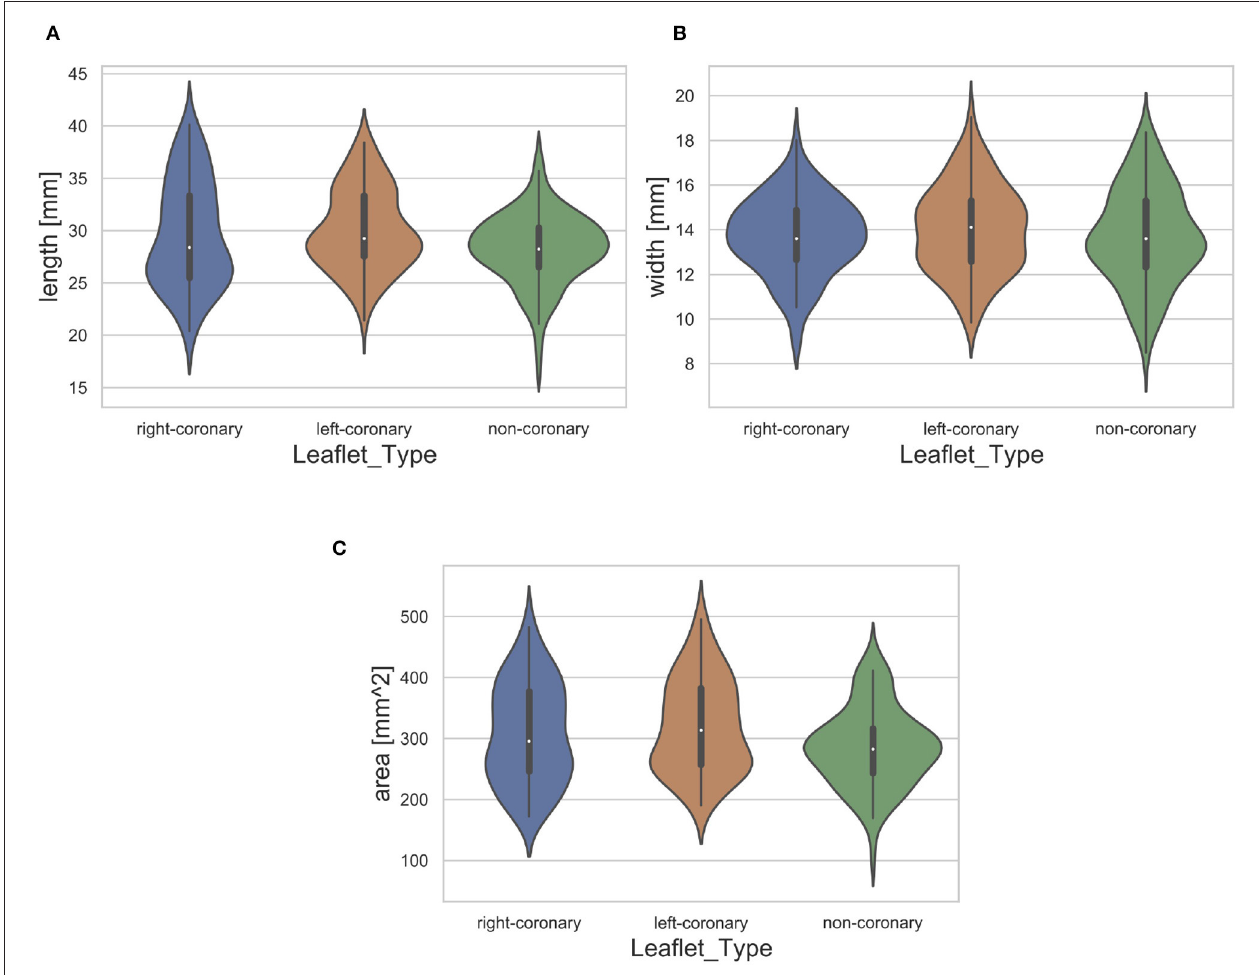
FIGURE 3 | Distribution of leaflet length (A) , width (B) , and area (C) with regard to the leaflet type. The white dot represents the median value.